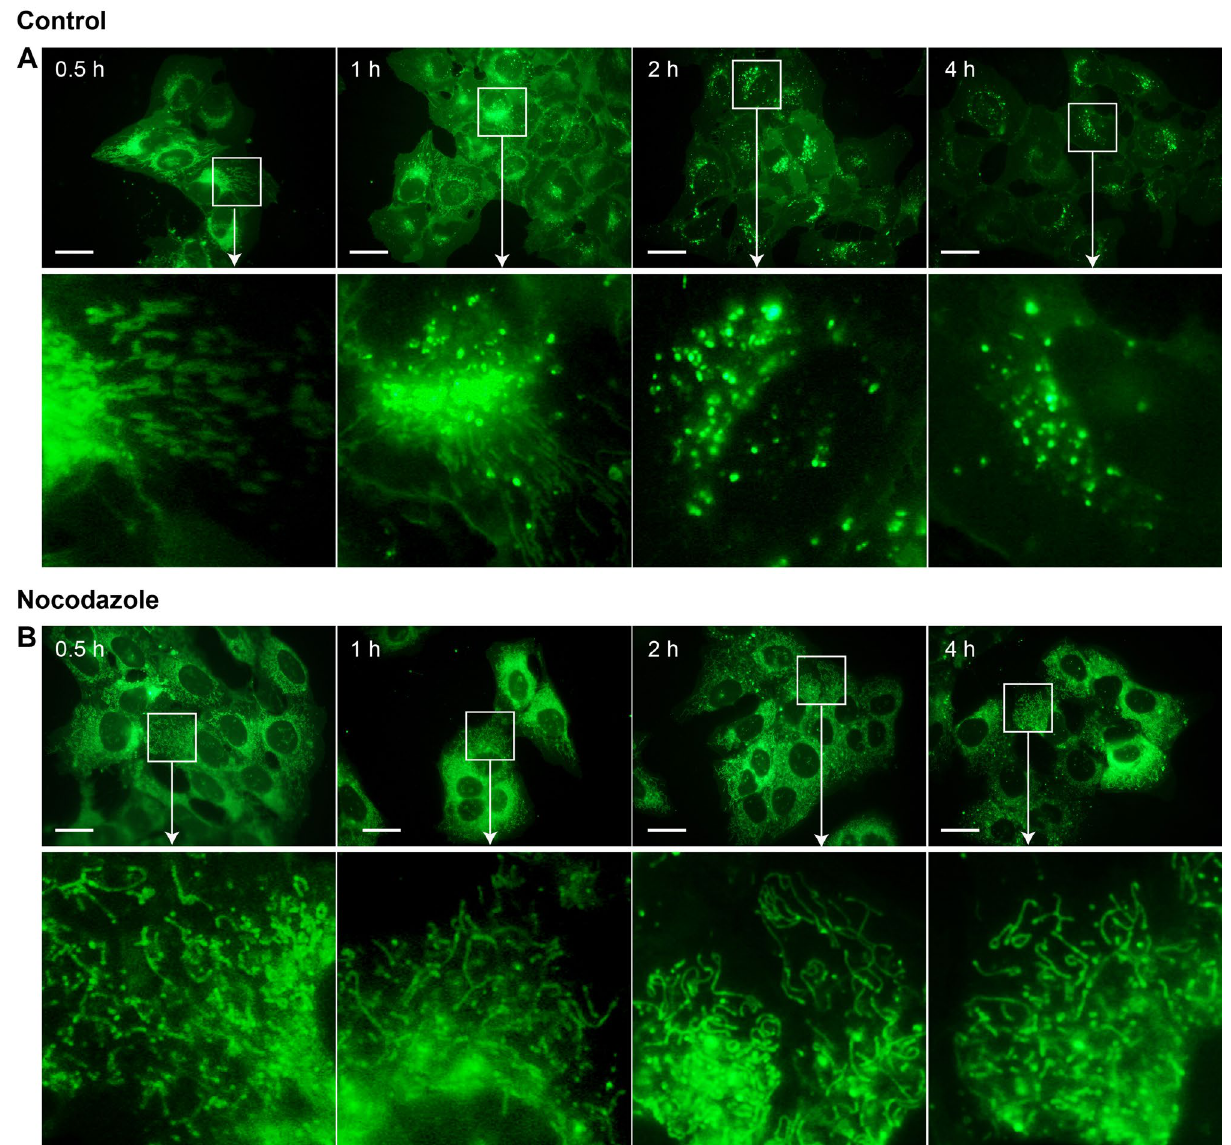
Figure 4. Nocodazole treatment prevents Sterolight redistribution to lysosomes. U-2 OS cells were pulsed with Sterolight probe (1 µg/ml) complexed with methyl-β-cyclodextrin for 1 min, washed, and chased for indicated time at 37 °C in the absence (control A) or presence of 50 µM nocodazole (B). Magnifications of the regions indicated by the white boxes are shown below. The presented results are representatives of three independent experiments. Scale bar 10